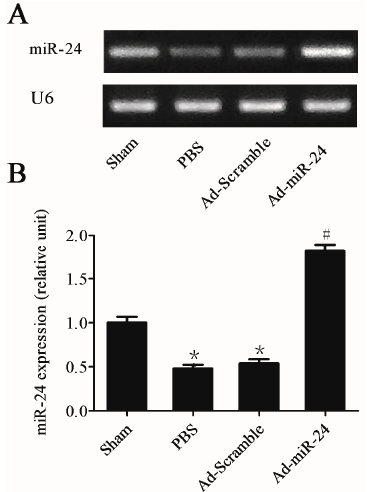
Figure 2. The expression level of microRNA-24 (miR-24) in carotid arteries. ( A , B ) Quantitative Real-Time PCR (qRT-PCR) gel ( A ) and quantitation ( B ) from the four groups for U6 (internal control of miRNA) and miR-24. The carotid artery balloon injury induced down-regulation expression of miR-24, while adenovirus (Ad-miR-24) transfection up-regulated its expression level (Compared to Sham group, * p < 0.05; Compared to phosphate buffer saline (PBS) group or Ad-Scramble group, # p < 0.05, n = 6). However, compared with the PBS group, Ad-Scramble could not increase the expression of miR-24.